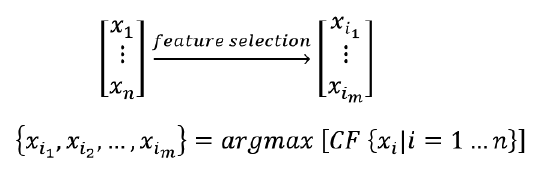
Figure 2. The feature selection